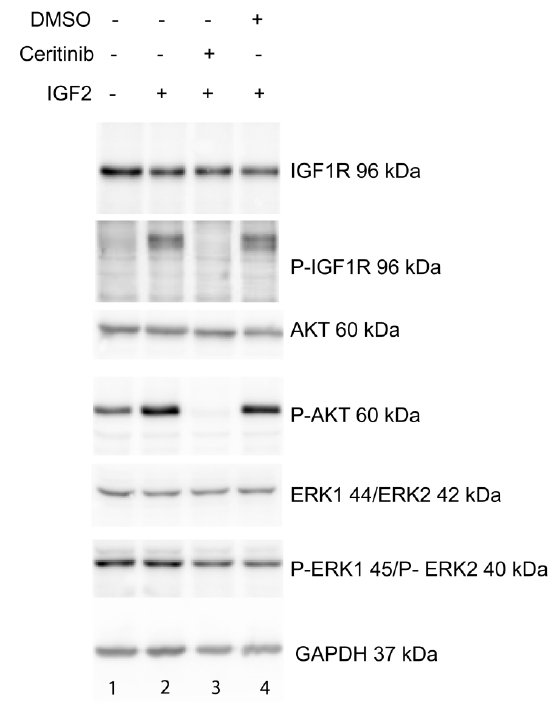
Figure 5. Ceritinib acts via the IGF1R / AKT pathway: PhKh1 cells were stimulated after starvation with IGF2 in the presence or absence of ceritinib or vehicle (DMSO). The expression of IGF1R, AKT, ERK1 / ERK2, and their respective phosphorylated forms (P-IGF1R, P-AKT, P-ERK1 / P-ERK2) was analyzed by western blot with specific antibodies. GAPDH was used as loading control. A representative experiment of three independent experiments is shown.